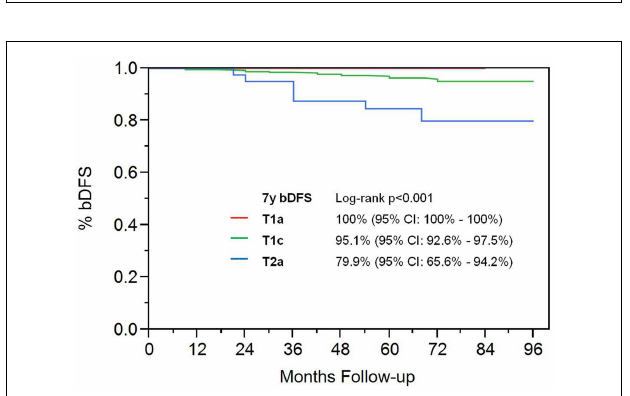
FIGURE 3 | Biochemical disease-free survival in intermediate-risk group patients . Patients were stratified into low intermediate-risk and high intermediate-risk based on Gleason score and PSA. Patients deemed to be intermediate-risk due to one factor alone, of either Gleason score 3 + 4 or PSA 10–20, were considered to be intermediate-risk. Patients with Gleason 4 + 3 or 3 + 4 with PSA 10–20, were considered to be high intermediate-risk.